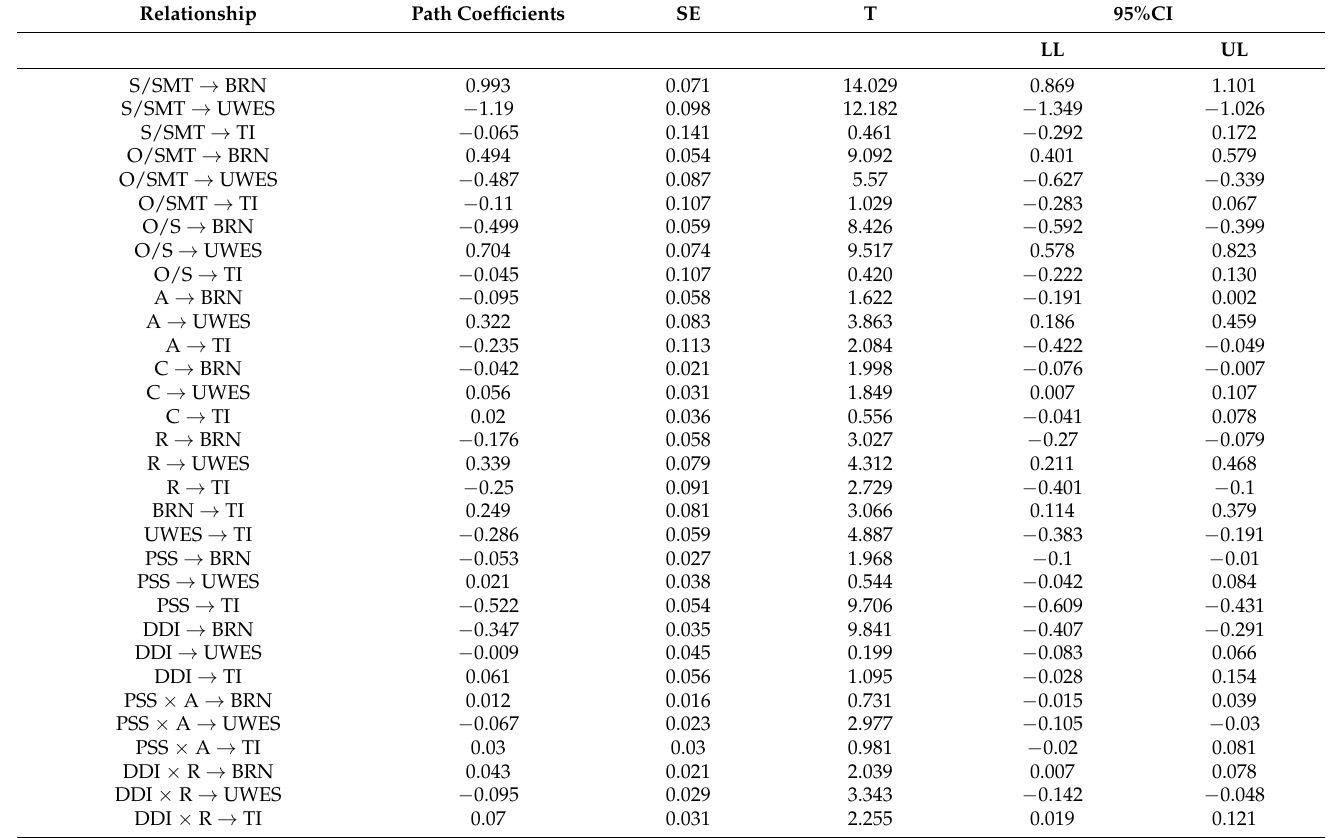
Table A10. Moderation Analyses—Direct and Interaction Effects.